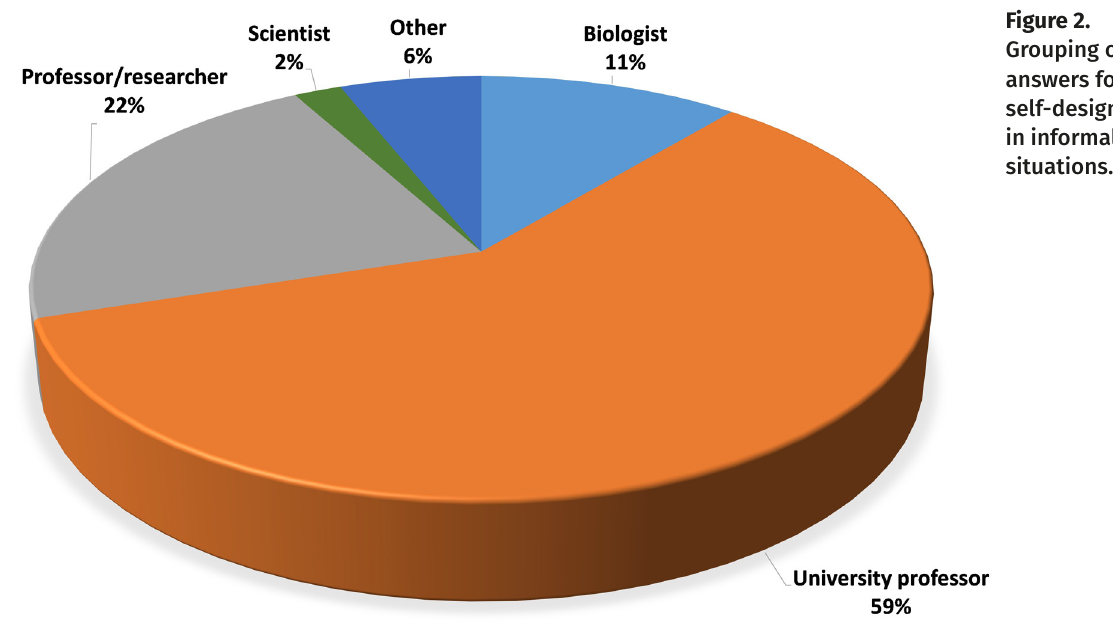
Figure 2. Grouping of answers for self-designation in informal